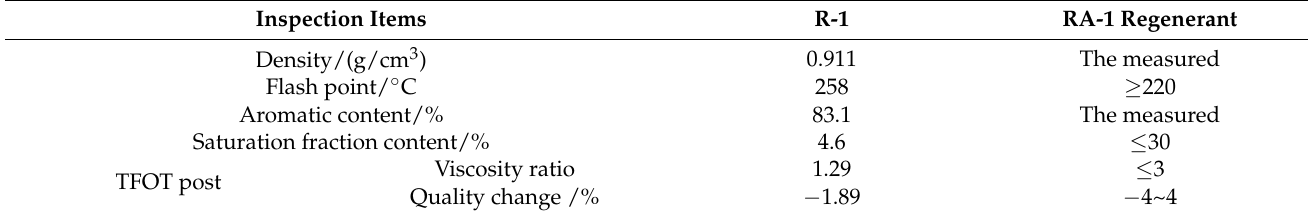
Table 2. Physicochemical properties of REOB.